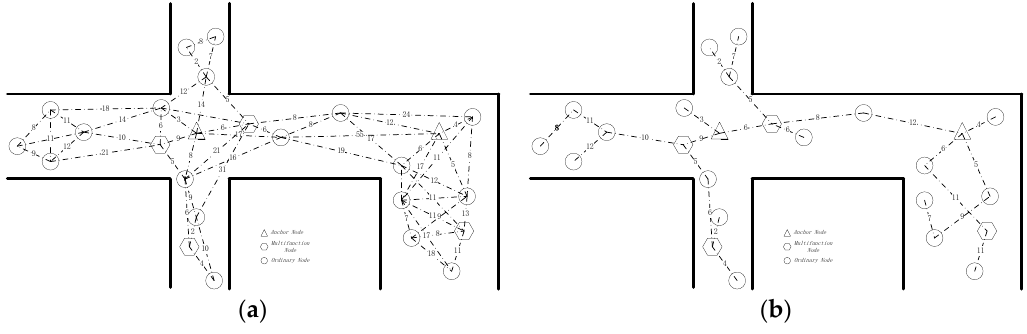
Figure 1. ( a ) Diagram of a node communication network in an underground mine. ( b ) Diagram after the DCMST is applied to the node communication network in an underground mine.